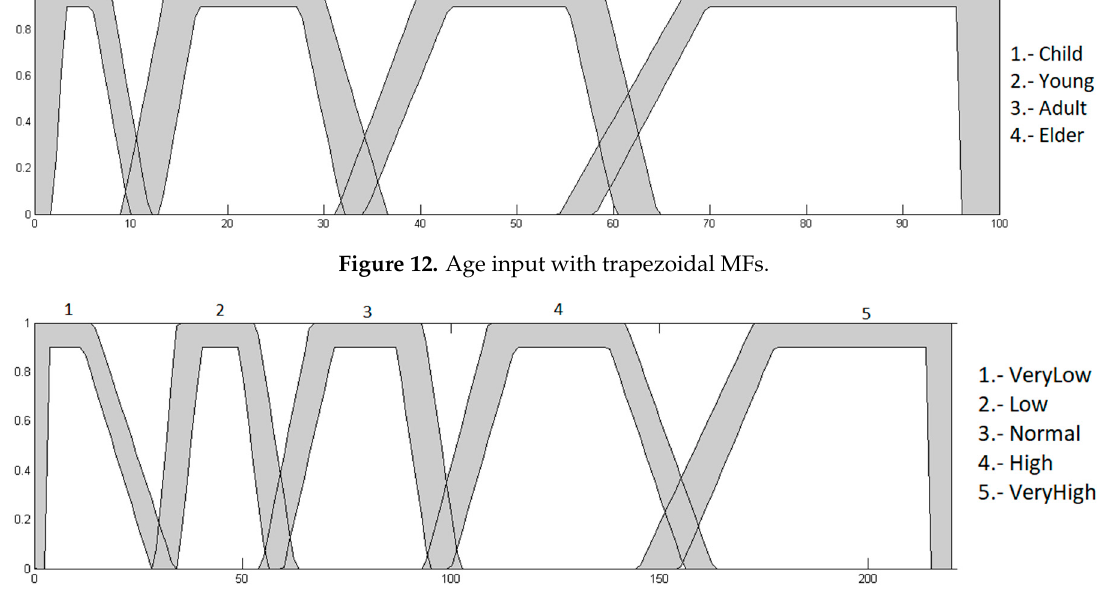
Figure 13. Input heart rate with trapezoidal MFs.